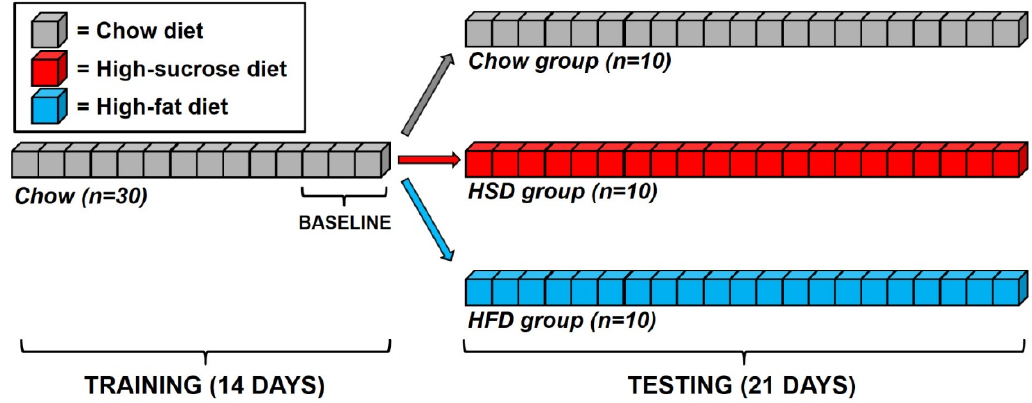
Figure 1. Schematic representation of the timeline of the study. Briefly, rats were trained to nose-poke respond to obtain 45 mg pellets of a standard chow diet under a fixed-ratio 1 (FR1) schedule of reinforcement for 14 days. Upon stabilization of responding, rats were matched and subdivided into three experimental groups: one set (10 rats) was assigned to a chow group (Chow) and received the same 45 mg pellets received in the training phase; a second set (10 rats) was assigned to a high-sucrose diet (HSD) group and received high-sucrose 45 mg pellets; a third set (10 rats) was assigned to a high-fat diet (HFD) group and received high-fat 45 mg pellets. Testing lasted 21 days.